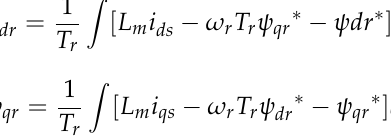
Figure 19. Simulink model of MRAS control.